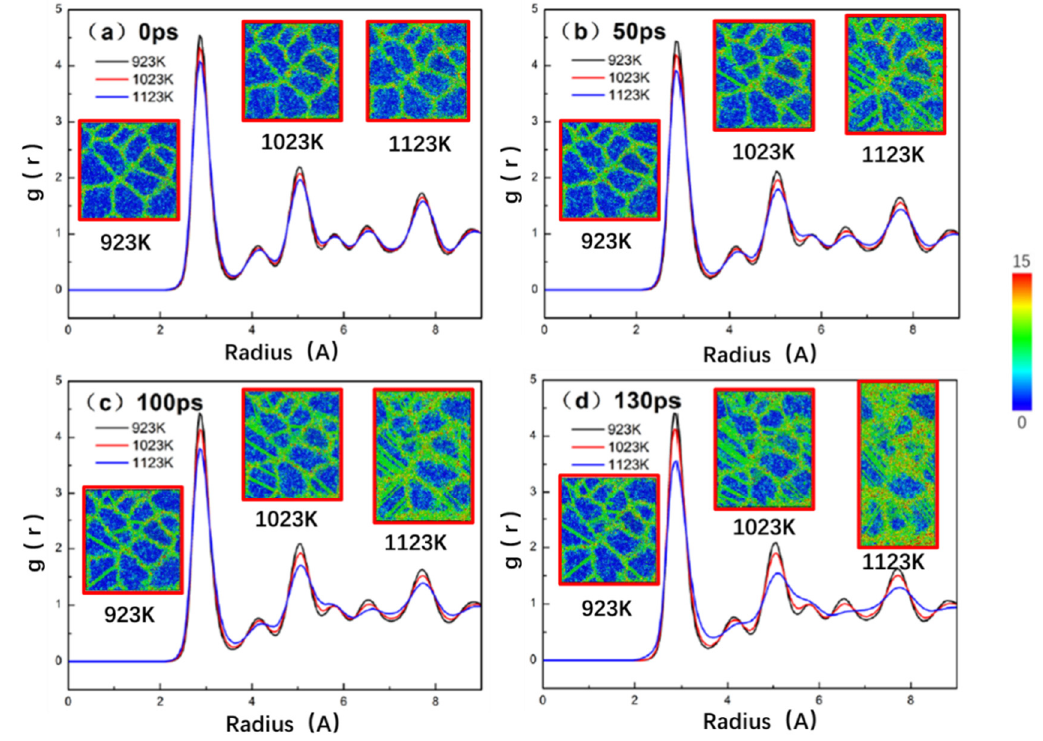
Figure 3. Radial distribution function plots with atomic snapshots of a representative nanocrystalline TiAl model with 4.6 nm coarser grain, colored as per CSP during creep deformation for ( a ) 0, ( b ) 50, ( c )100, ( d ) 130 ps under the stress levels of 1.4 GPa at 923 K, 1023 K, and 1123 K.